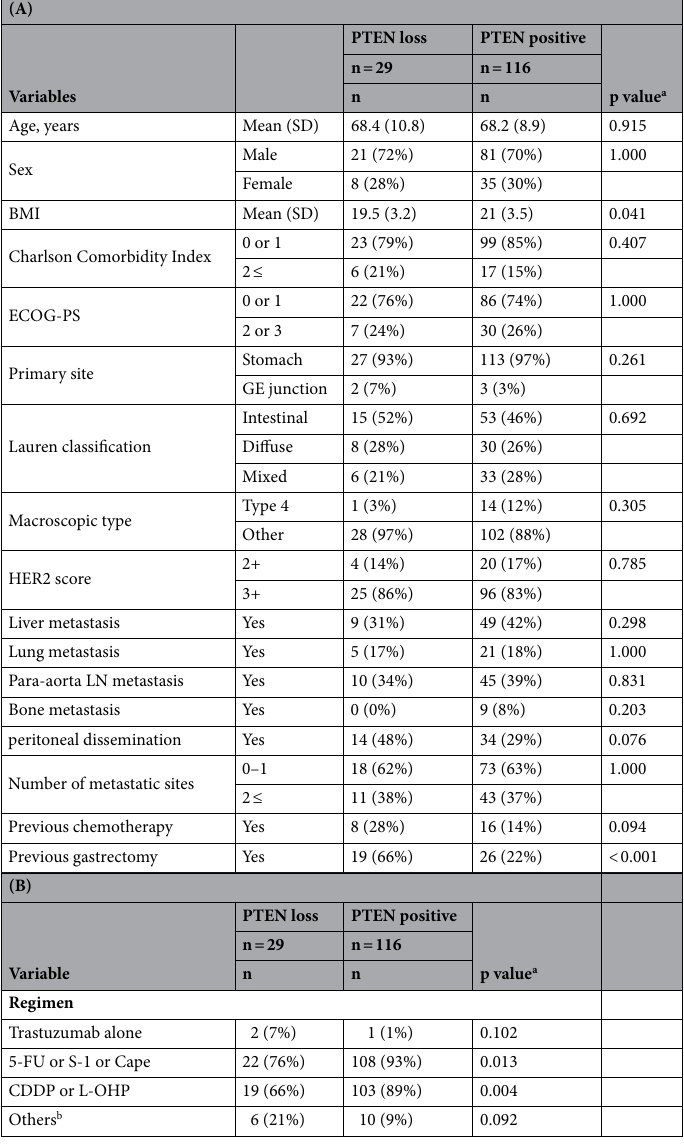
Table 2. Characteristics of patients and chemotherapy regimen with trastuzumab. (A) Characteristics of patients divided according to the phosphatase and tensin homolog (PTEN) status. (B) Chemotherapy regimen with trastuzumab. PTEN phosphatase and tensin homolog, GE gastroesophageal, HER2 human epidermal growth Factor Type2, 5-FU fluorouracil, S-1 tegafur/gimeracil/oteracil, Cape capecitabine, CDDP cisplatin, L-OHP oxaliplatin. a Fisher’s exact test and Student’s t test were used for categorical items and continuous variables, respectively. b Others include docetaxel, paclitaxel, and